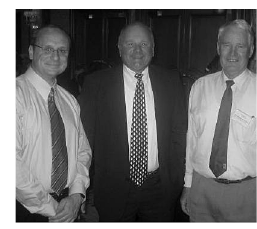
Figure 4: Workshop organisers: Mark Coghill (Principal Technologist, Rio Tinto Technical Services), David Boger (Laureate Professor, The University of Melbourne), Richard Jewell (Senior Consultant,